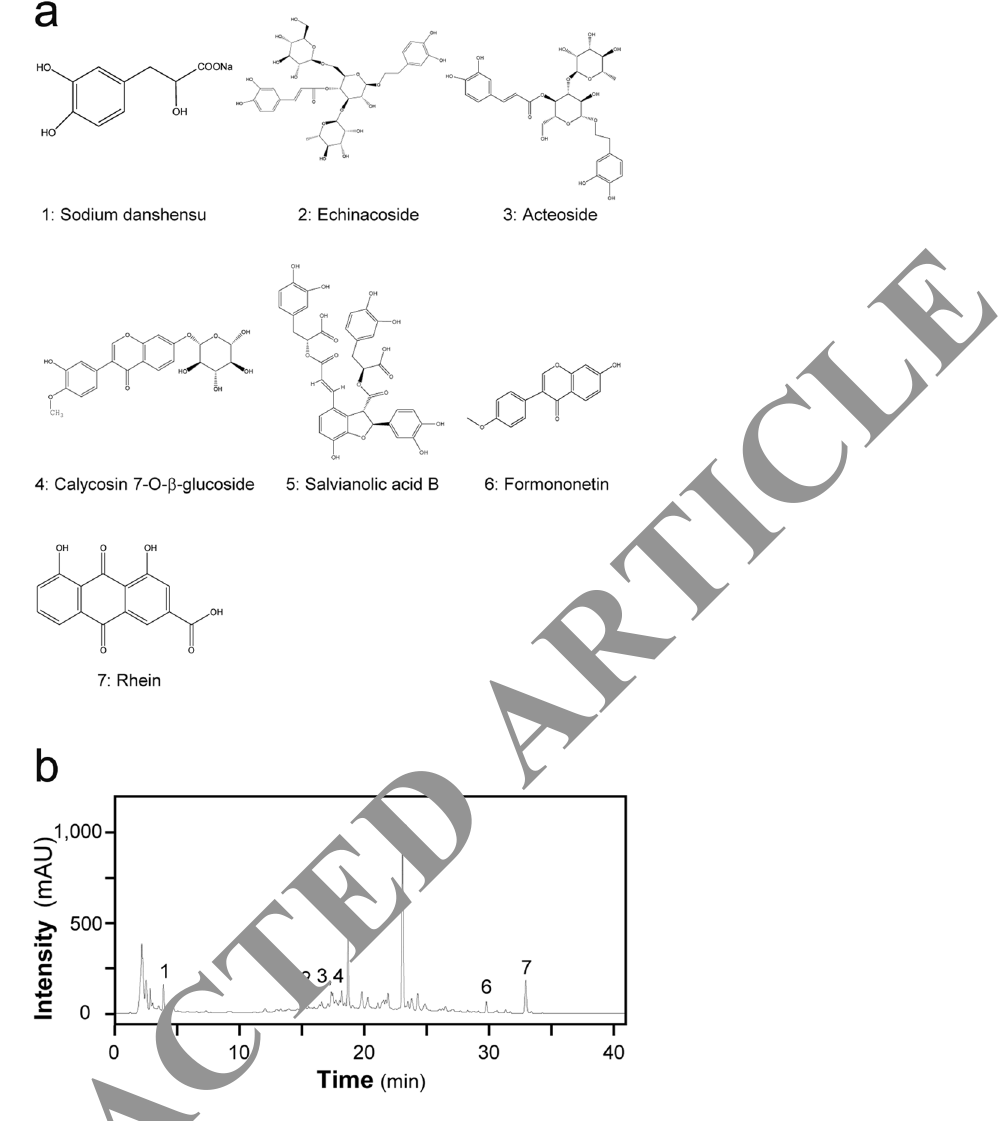
Figure 8. The main components of JPYS decoction extract were determined by HPLC. ( a ) Chemical structure of the main active ingredients of JPYS decoction. The denotation peaks 1–7 were sodium danshensu (1), echinacoside (2), acteoside (3), Calycosin-7-O- β -D-glucopyranosid (4), salvianolic acid B (5), formononetin (6) and rhein (7). ( b ) HPLC fingerprint profile of JPYS decoction extract at 260